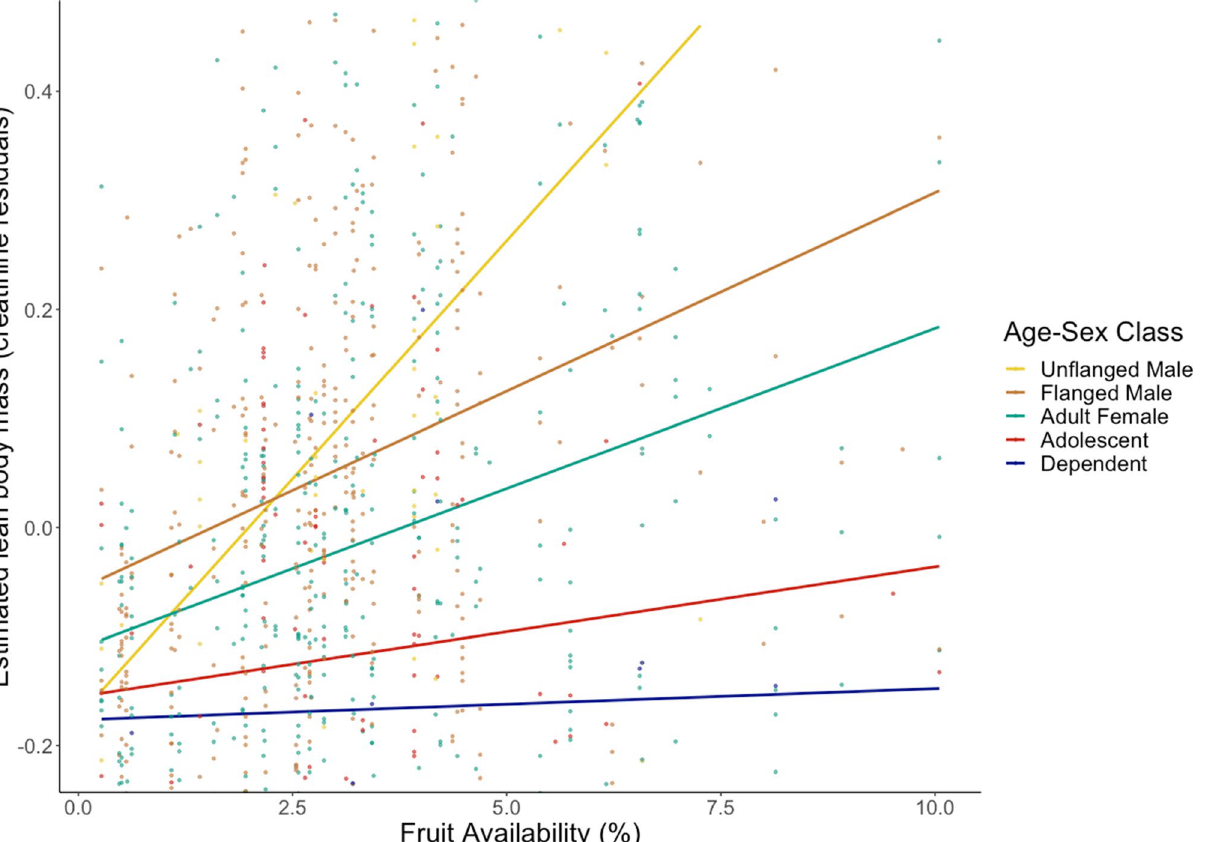
Figure 1. Linear regression lines describing the relationship between fruit availability and ELBM (residual creatinine) by age-sex